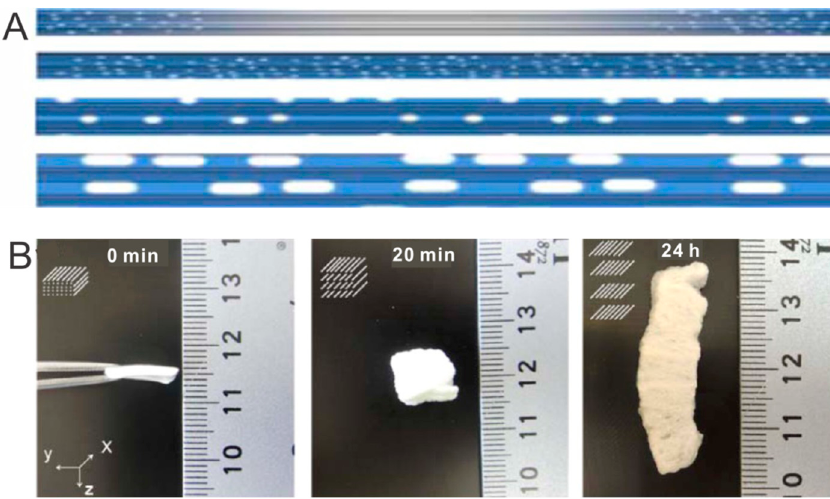
Figure 1. Expanded 3D aligned fibrous scaffolds: ( A ) schematic representation of expansion of 2D nanofiber membranes to 3D fibrous scaffolds using a modified gas-forming technique. ( B ) photographs of aligned PCL fiber mats after treatment with 1 M NaBH 4 for 0 min, 20 min, and 24 h. Reprinted from Reference [15].